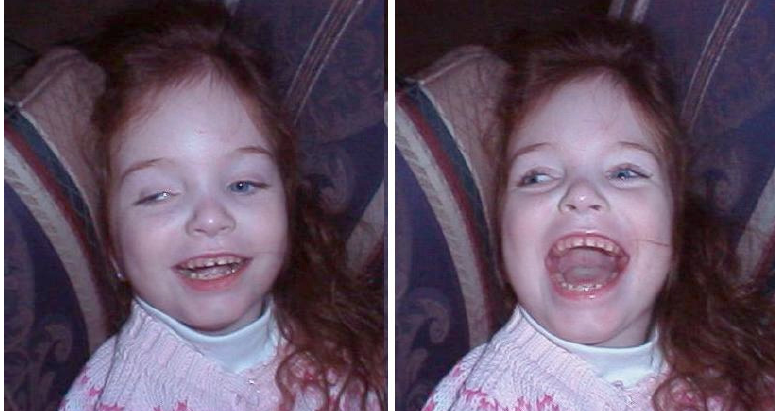
Figure 8. The emotional reaction of a young hydranencephalic girl. (We thank Bjorn Merker for the use of these photographs, reproduced with permission of the child’s mother